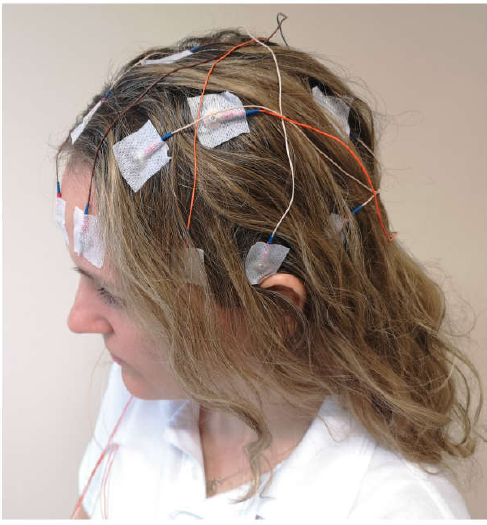
Figure A1. Option 1: EEG Inpatient Monitoring.